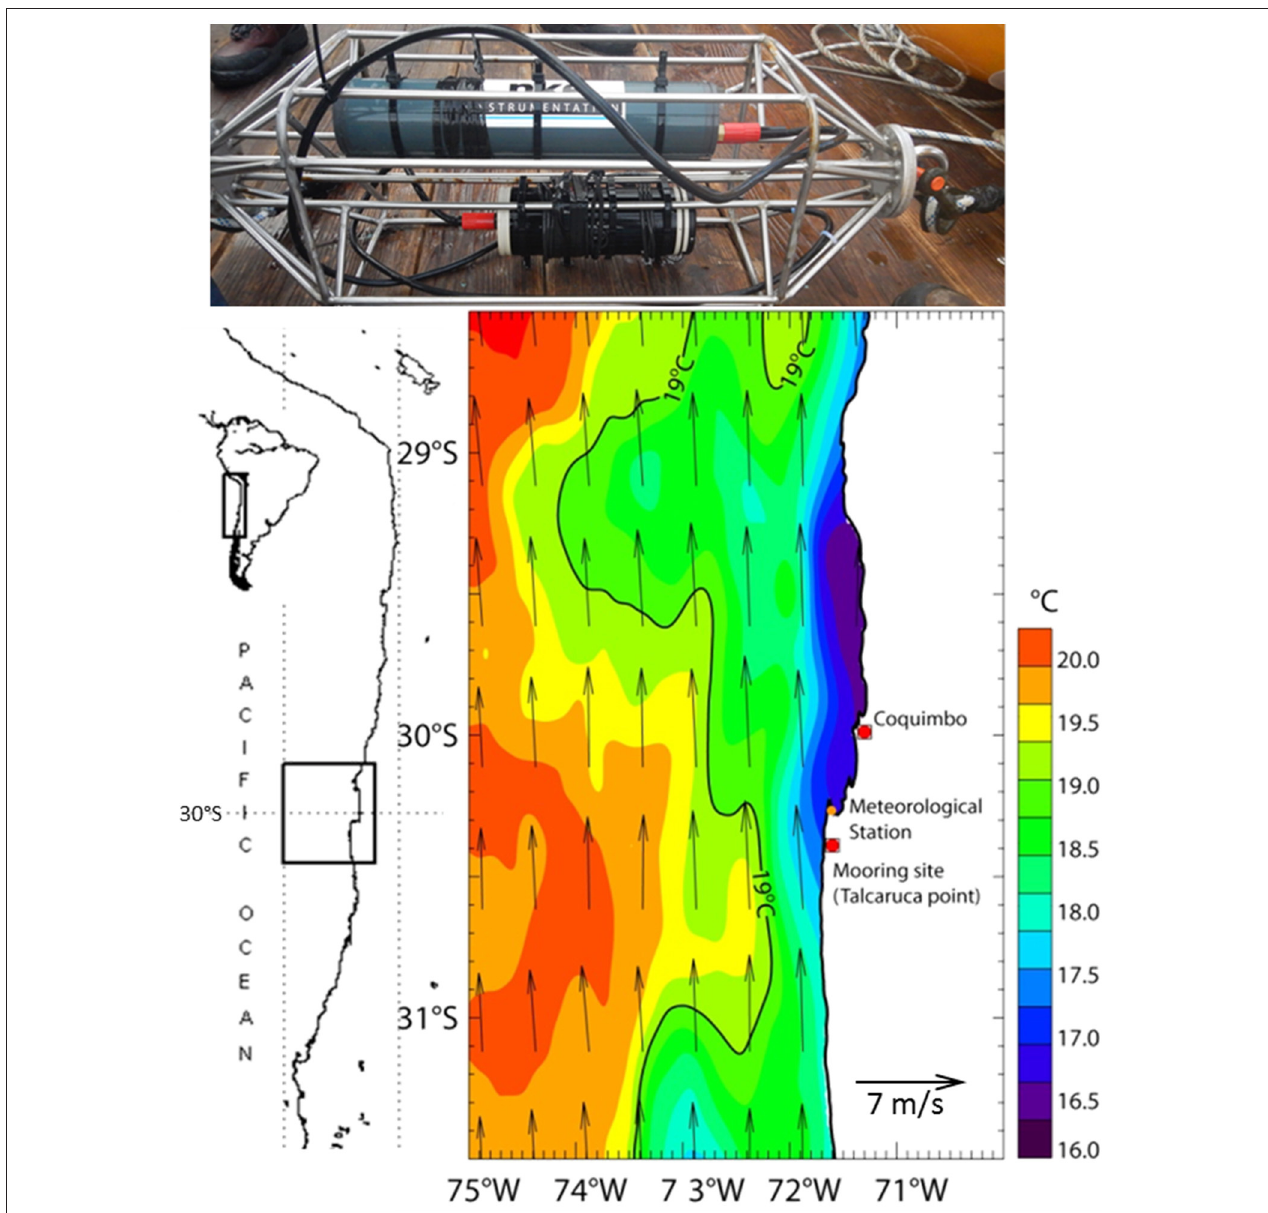
FIGURE 6 | Stainless steel cage equipped with the silicate electrochemical sensor (Bottom) and its battery pack (Top) ready to be deployed at 55m depth on a mooring off-shore Coquimbo, Chile at Talcaruca Point shown on the sea surface temperature and winds map derived from the Multi-scale Ultra-high Resolution (MUR) (0.01 ◦ ) and ASCAT (0.25 ◦ ), respectively. Average for the deployment period 16/04/2017-23/04/2017 - • indicates the location of the meteorological station (Punta Lengua de Vaca) of CEAZA.